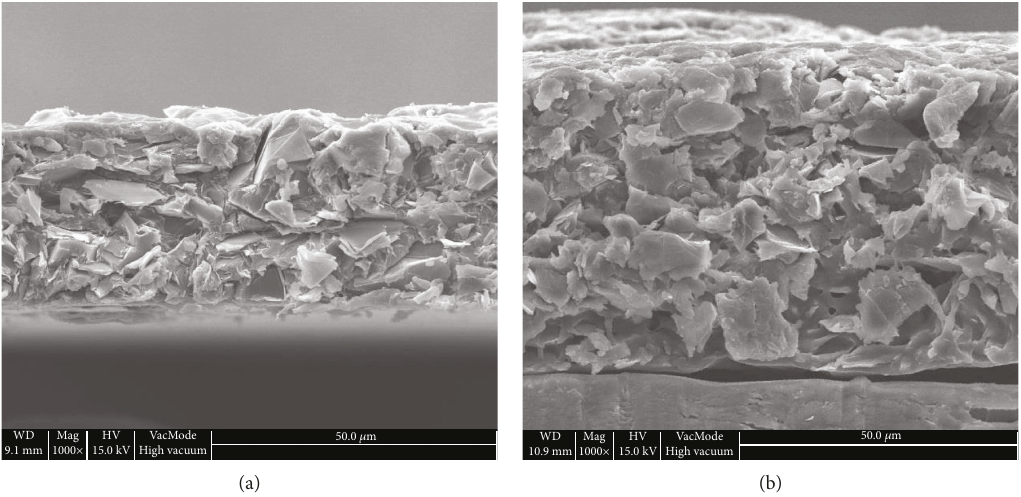
Figure 3: Cross-sectional FE-SEM images of (a) PMMAGr and (b) PBGr fi lms containing 40 wt.% of graphite.